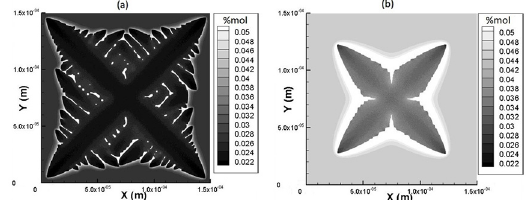
Figure 4: Dendrites calculated by the phase-field model for different initial concentrations ( C ) of copper, Al-2.64×10 –2 mol%Cu (a) and 0 Al-4.5×10 –2 mol%Cu (b).